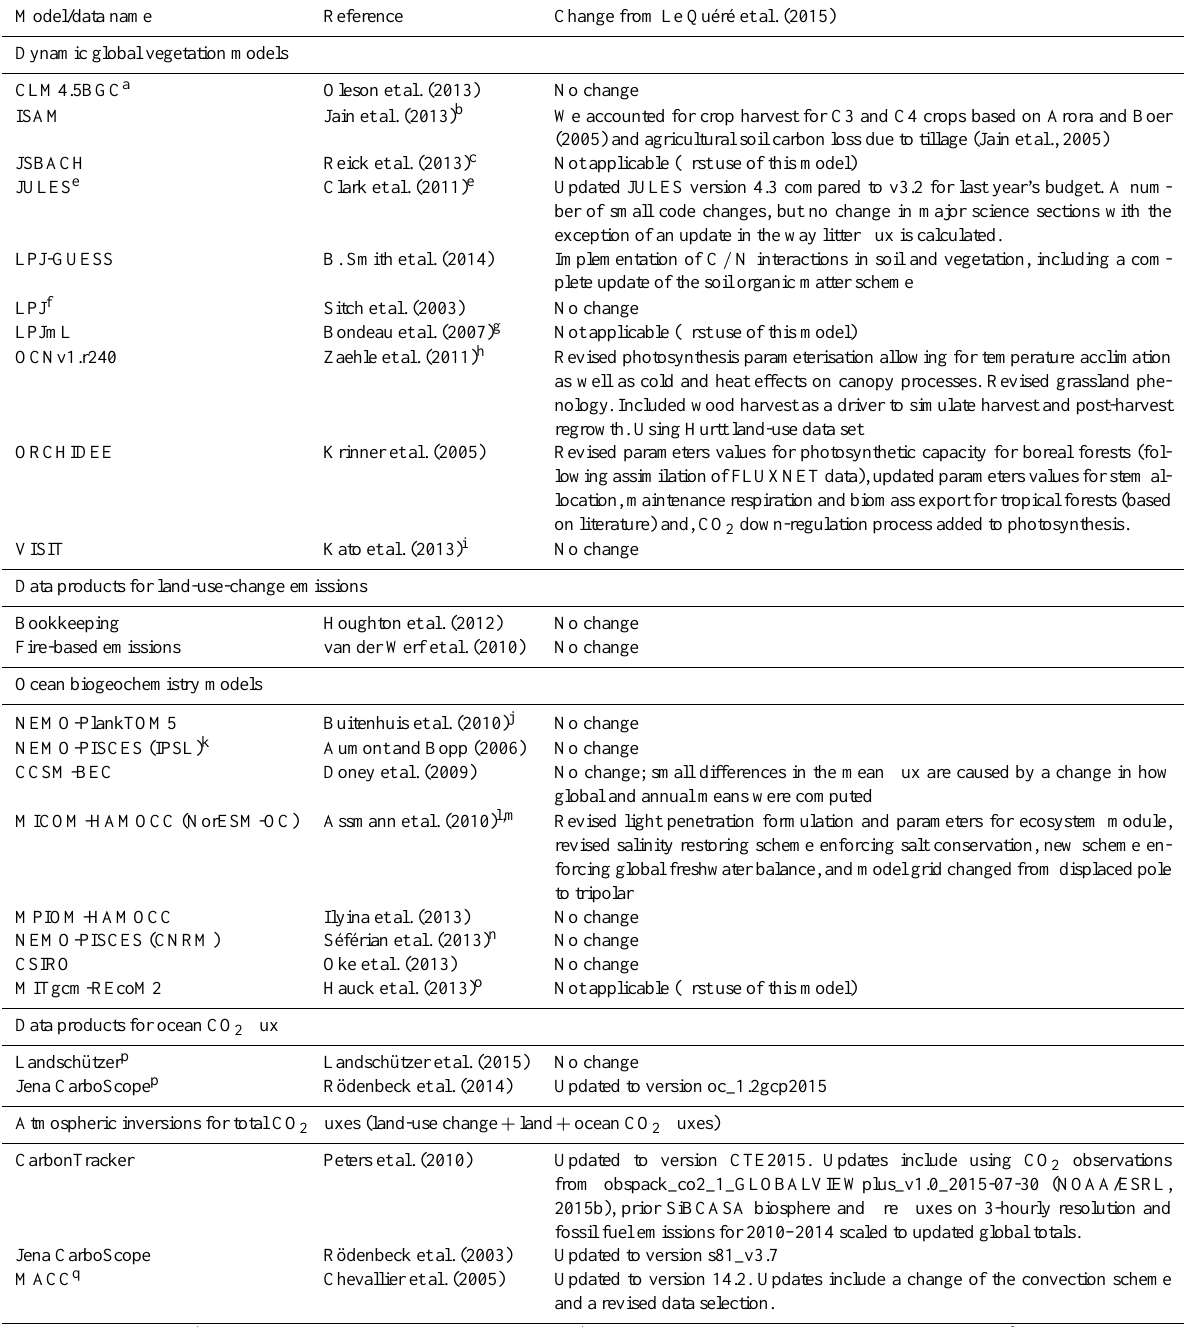
Table 6. References for the process models and data products included in Figs.